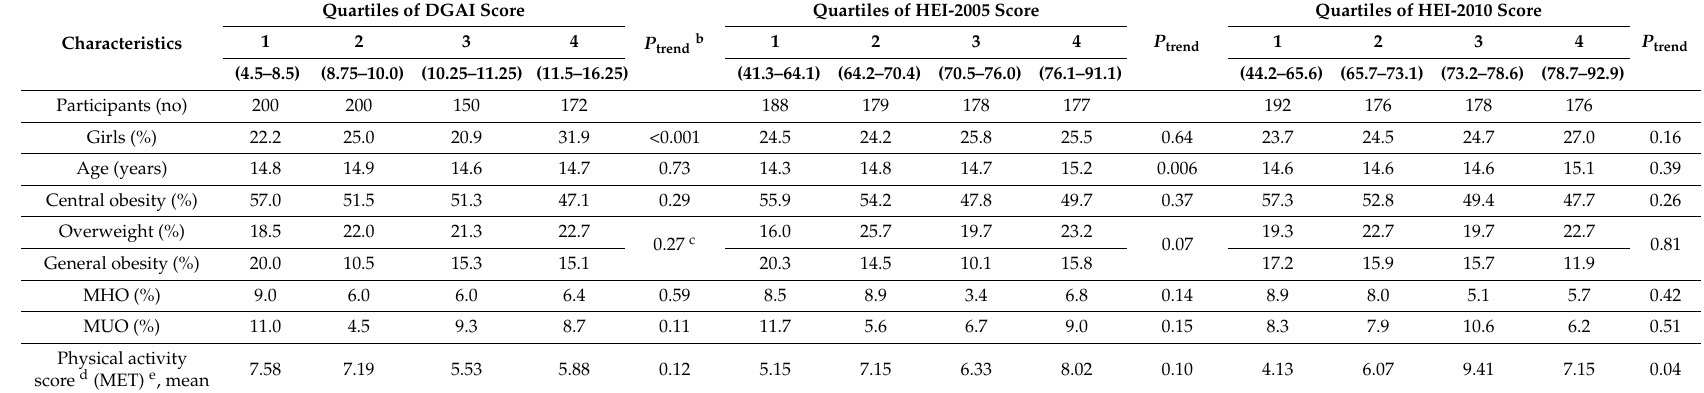
Table 3. Participant characteristics according to quartile categories of diet quality indices score in the Tehran Lipid and Glucose Study adolescents a .